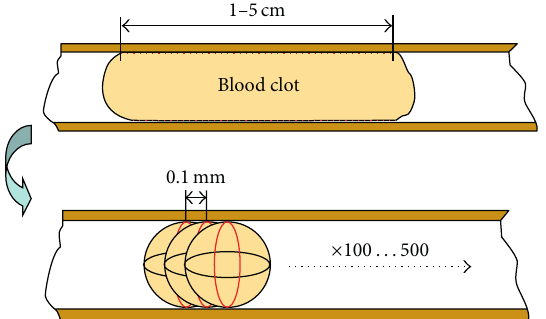
Figure 2: Surface tension from some